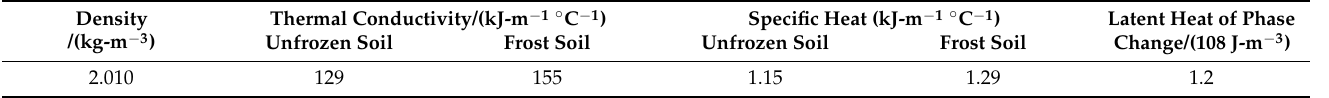
Table 2. Soil parameters.